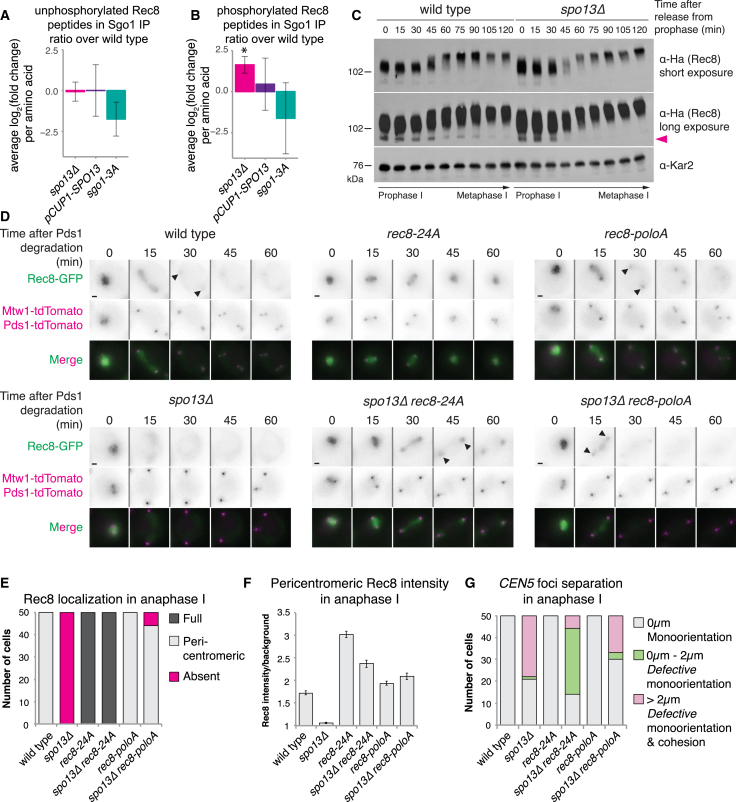
Cohesin Phosphorylation Is Required for Loss of Sister Chromatid Cohesion in spo13Δ Cells(A and B) Average per residue ratio of log2(fold enrichment over wild type) of Rec8 non-phospho- (A) and phosphopeptides (B) in three replicate Sgo1 immunoprecipitates from cells harvested 75 min after release from prophase (metaphase I). Error bars represent standard deviation (∗p < 0.05, one sample t test).(C) Immunoblot analysis of Rec8-3Ha and Kar2 loading control.(D–G) Effect of SPO13 deletion on localization of Rec8-GFP and phosphomutant variants. (D) Representative images from time-lapse series. Scale bars, 1 μm. Arrows indicate pericentromeric Rec8-GFP. (E) Scoring and (F) intensity of pericentromeric Rec8-GFP with standard error bars. (G) Heterozygous CEN5-GFP distances as in Figure 2E using Pds1-tdTomato as anaphase I marker.See also Figure S4.